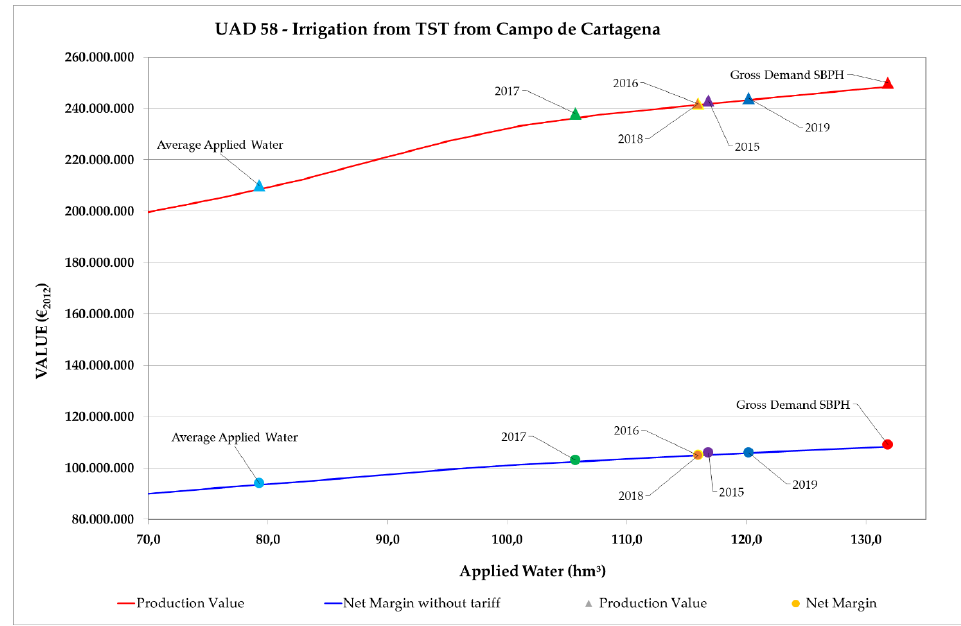
Figure 7. Demand curve of the production value and net margin of the UAD 58, Demand SBHP 2015/21, average applied water and years of drought (2015, 2016, 2017, 2018 and 2019). Source: SBHP 2015/21 Own elaboration.